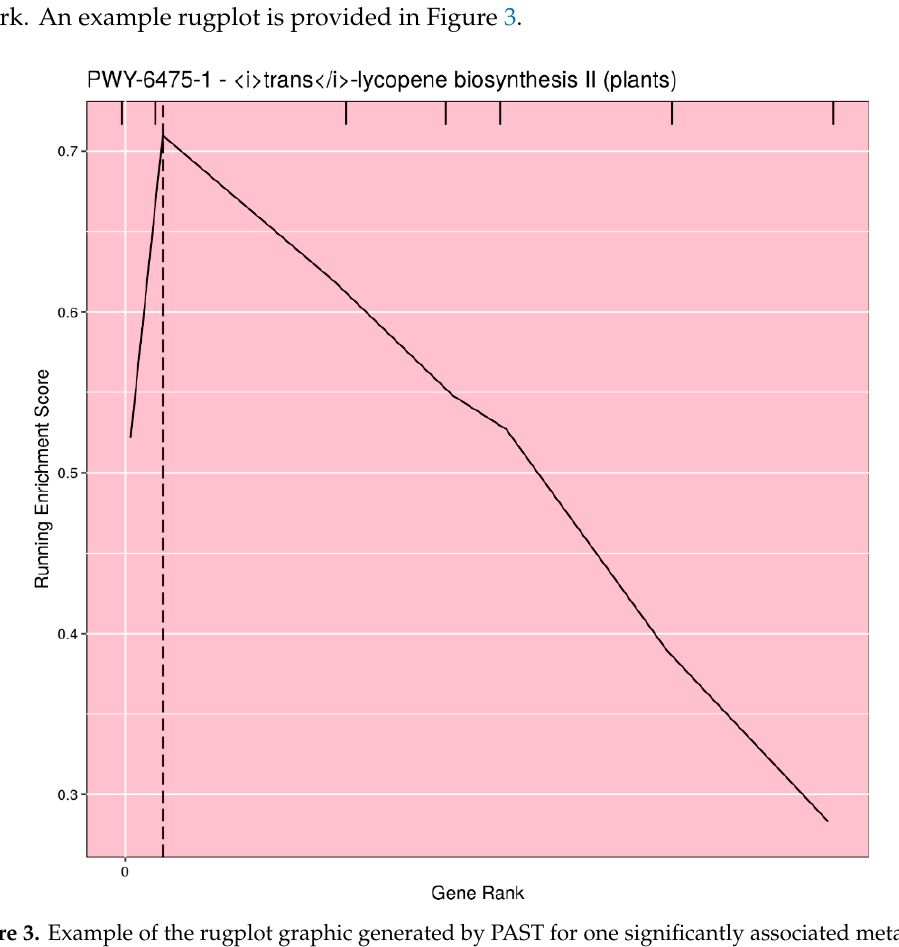
Figure 3. Example of the rugplot graphic generated by PAST for one significantly associated metabolic pathway. The X-axis shows the rank of each gene effect value; the Y-axis shows the value of the enrichment score (ES) running sum statistic as each consecutive gene effect value is processed. The x-intercept line indicates the highest point of the ES. Small hatch marks at the top of the image indicate the rank position of the effect of all genes in the pathway.